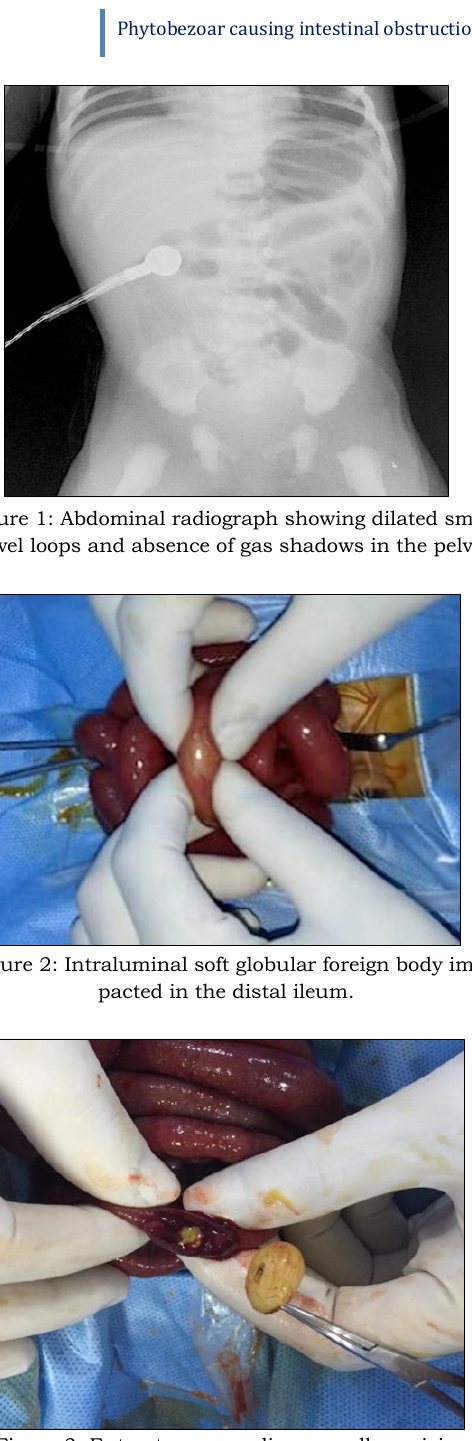
Figure 3: Enterotomy revealing a swollen raisin impacted in the distal ileum A diagnosis of intestinal obstruction was made; how- ever, the clinical and radiological features did not point at any likely etiology. As the patient had acute intesti- nal obstruction, he was taken up for emergency explor- atory laparotomy. The intraoperative findings showed dilated small bowel loops with an intraluminal soft, globular foreign body impacted in the distal ileum (Fig.2). The bowel was opened longitudinally over the foreign body which was found to be a swollen